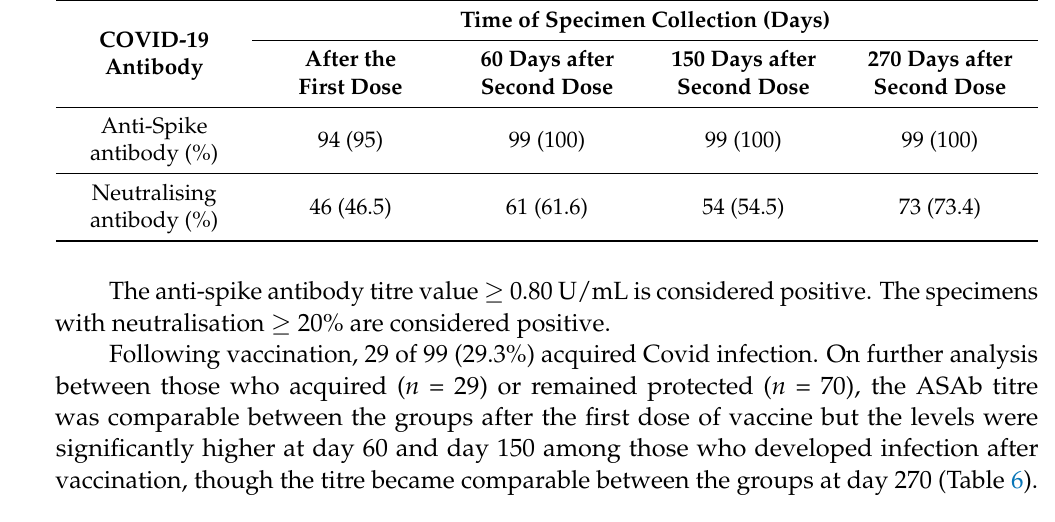
Table 6. Comparison of COVID-19 antibody response between those who acquired COVID-19 infection ( n = 29) or not ( n = 70) after the second dose of vaccine in the cohort of those without detectable anti-spike antibody before vaccination ( n =